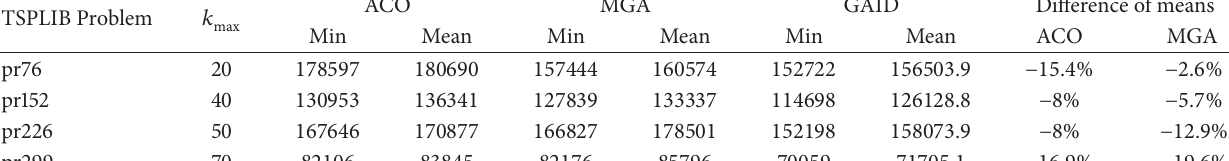
Table 1: Comparison between the proposed GAID, the Ant Colony Optimization, and the Modified Genetic Algorithm methods. Results are averaged over 100 simulations. The number of targets is included in the TSPLIB problem name. 𝑘 agent can visit. For each case, the fixed number of 𝑚 = 5 agents is considered, starting from the same location (one-depot problem). Only the greedy initialization method is used.